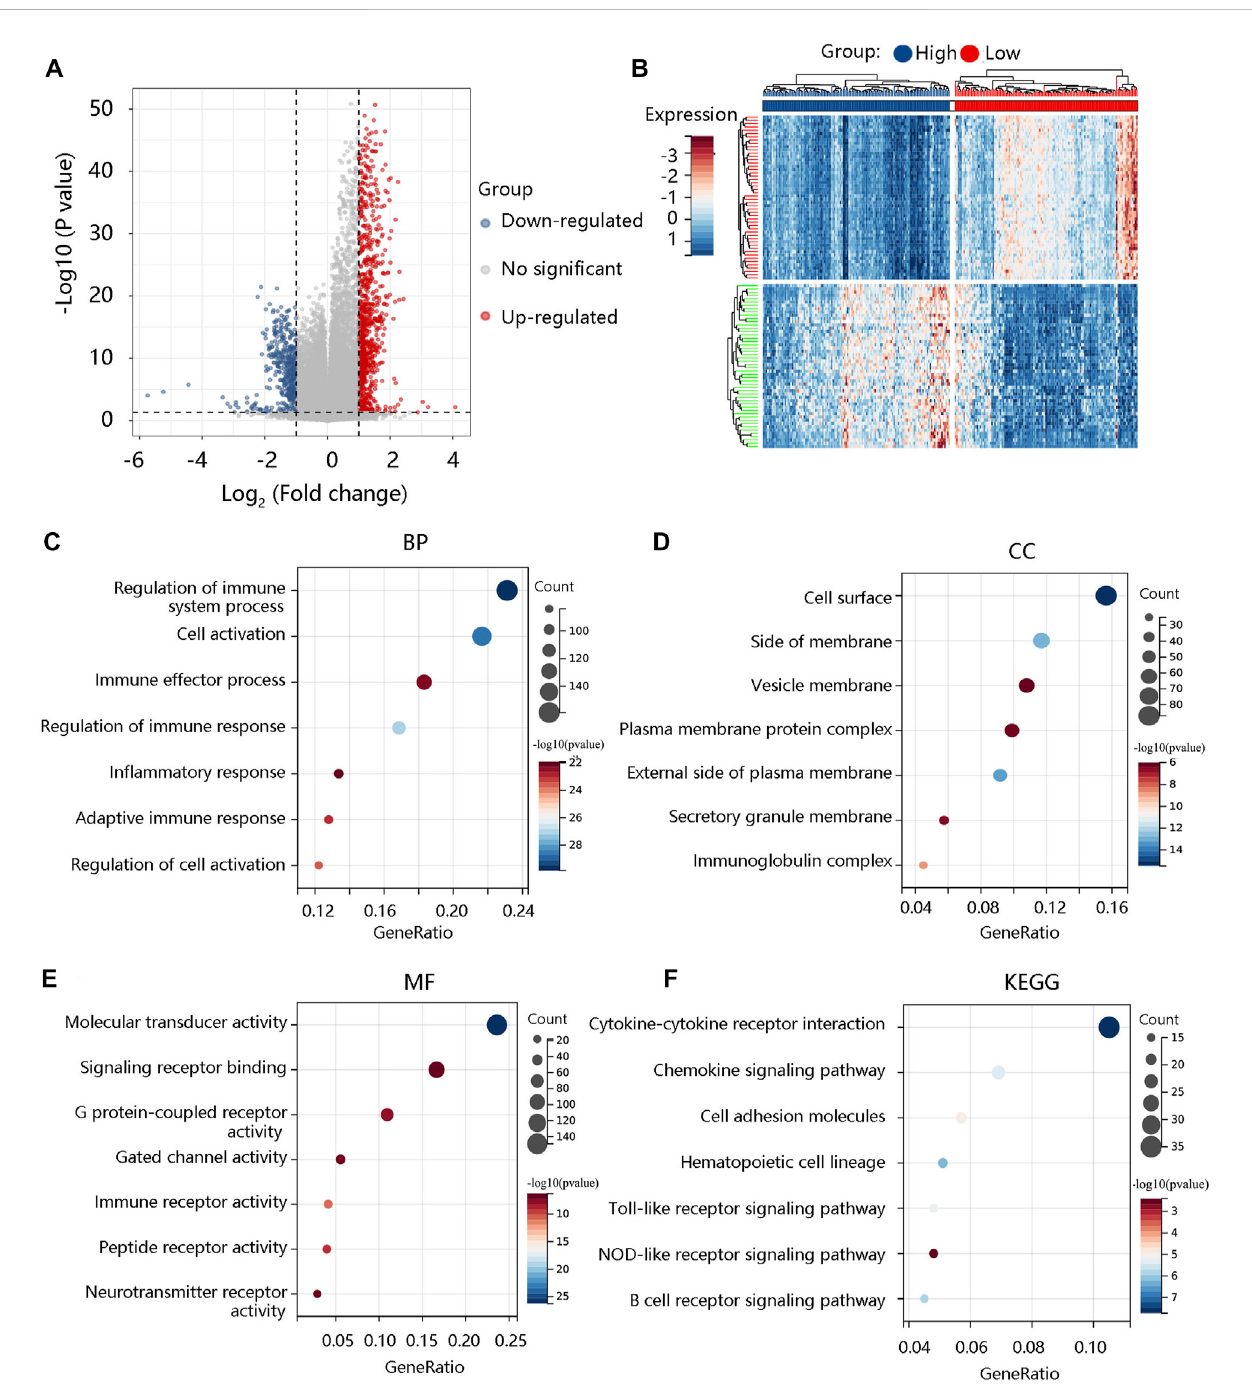
FIGURE 10 The functional enrichment analysis of the signi fi cant differentially expressed genes (DEGs). (A) The volcano plot exhibiting all the DEGs between low- grade glioma and normal groups. (B) The heat map showing the top 50 DEGs. The (C) BP, (D) CC, (E) MF, and (F) KEGG of the signi fi cant DEGs. BP, biological process; CC, cellular component; MF, molecular function; KEGG, Kyoto Encyclopedia of Genes and